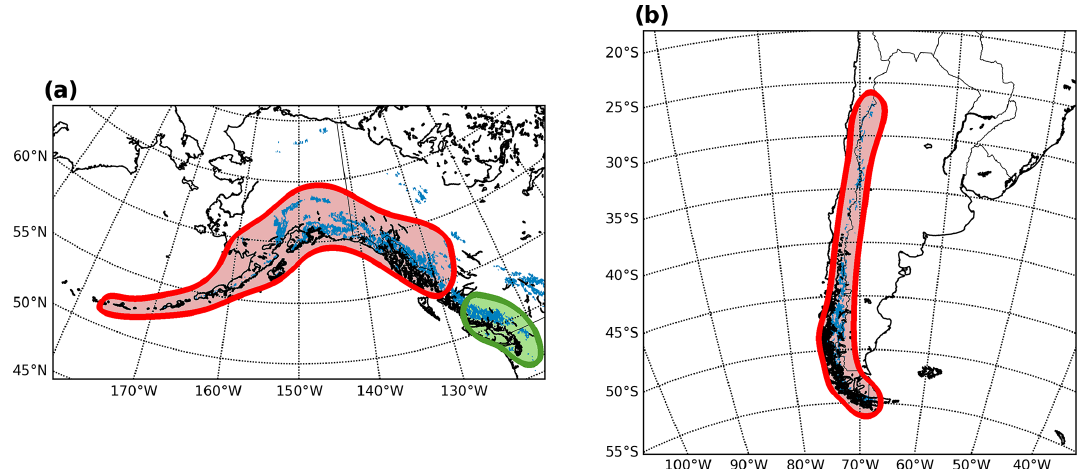
Figure 2. Surface lateral extent of the regions for which the underlying Earth structure (lithospheric thickness and sub-lithosphere viscosity profile) deviate from the adopted global values: panel (a) shows the extent for RGI regions 1 (red) and 2 (green), while panel (b) shows the extent for region